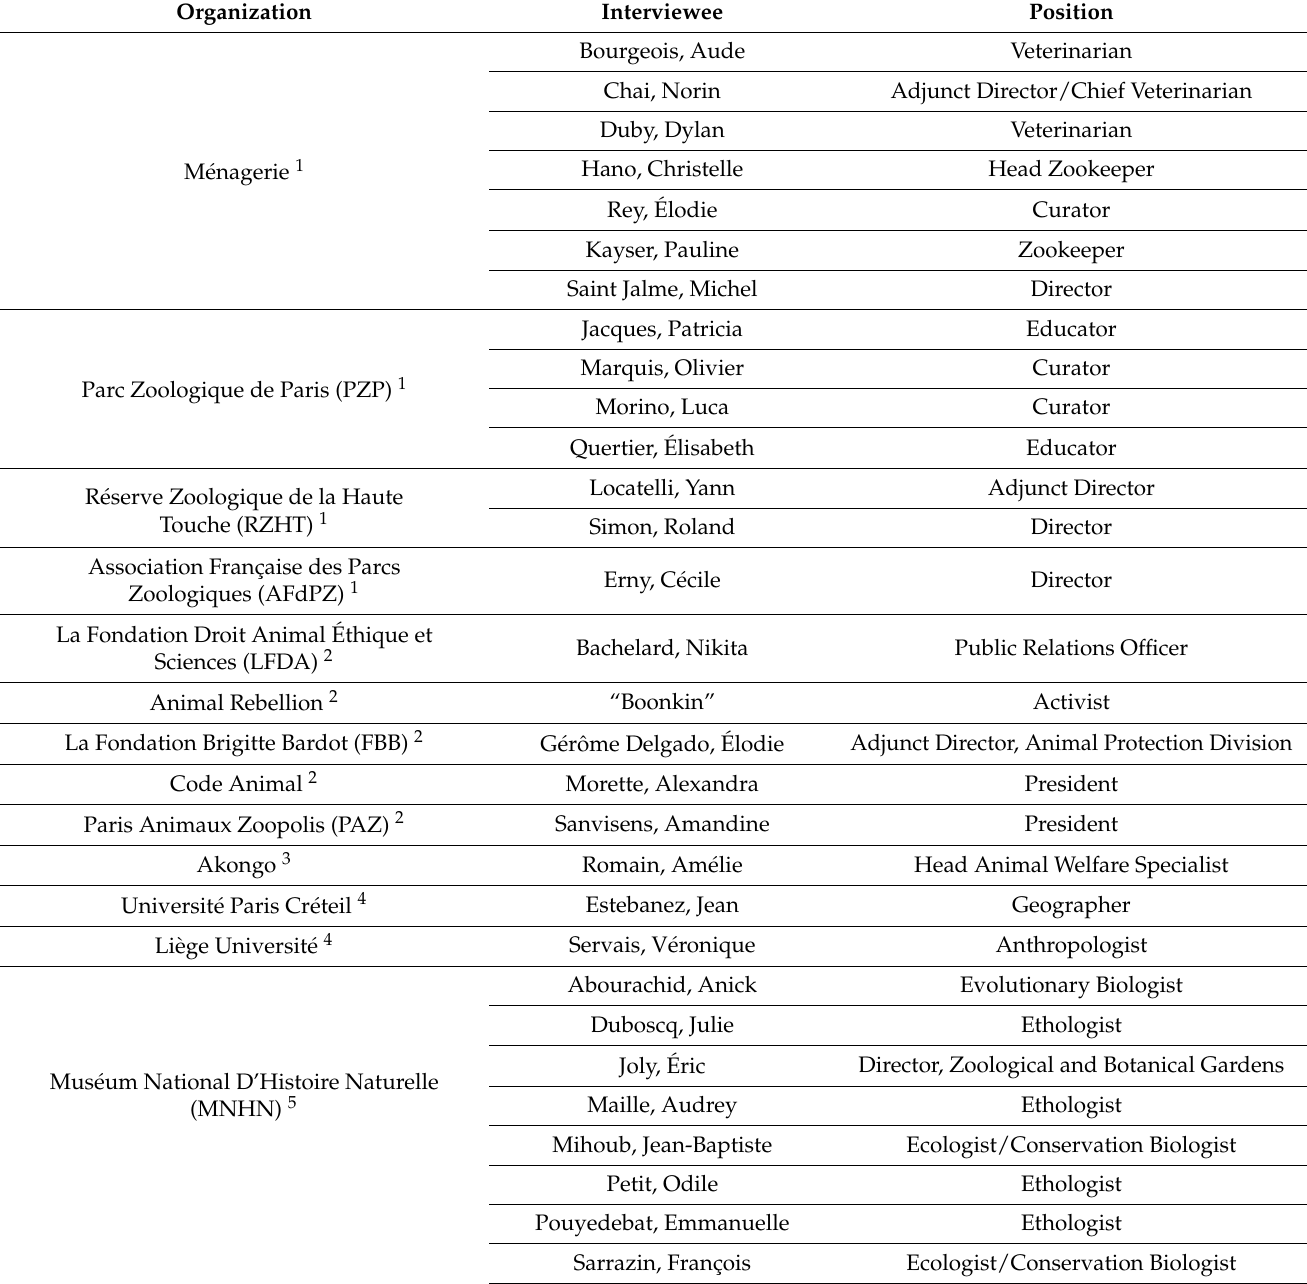
Table 1. Thirty-one interviews conducted in France from May to August 2019 and from March